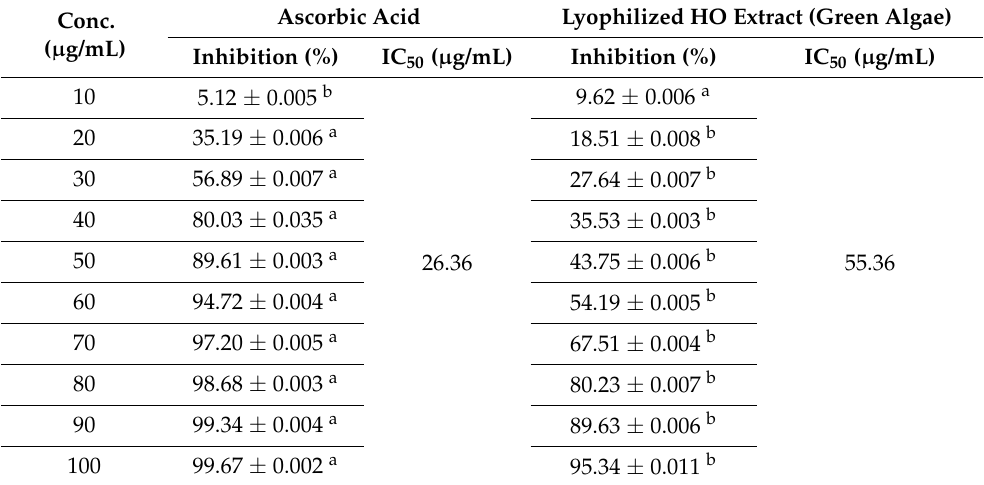
Table 2. DPPH radical scavenging capacity of lyophilized HO extract comparing with ascorbic acid as standard.